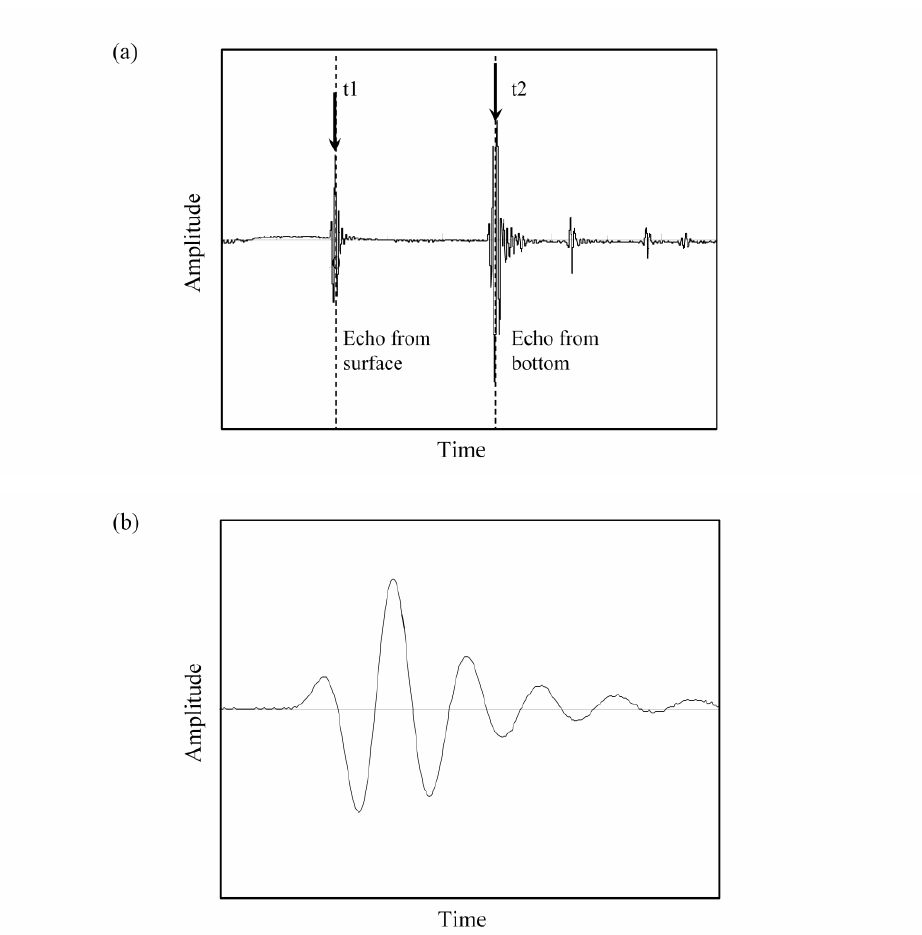
Fig. 2 Typical waveform of ultrasound echo. (a) Echoes from the surface and bottom of a specimen were recorded. The times to peak amplitude were recorded as t1 and t2. (b) Enlarged waveform of echo from surface of